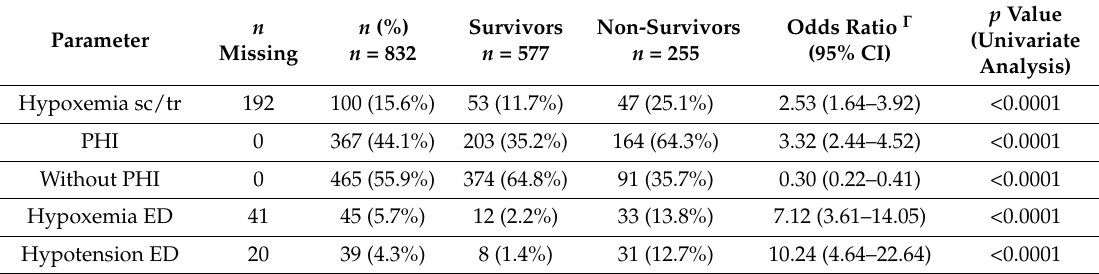
Table 2. Secondary insults and effect on outcome at 14 days.